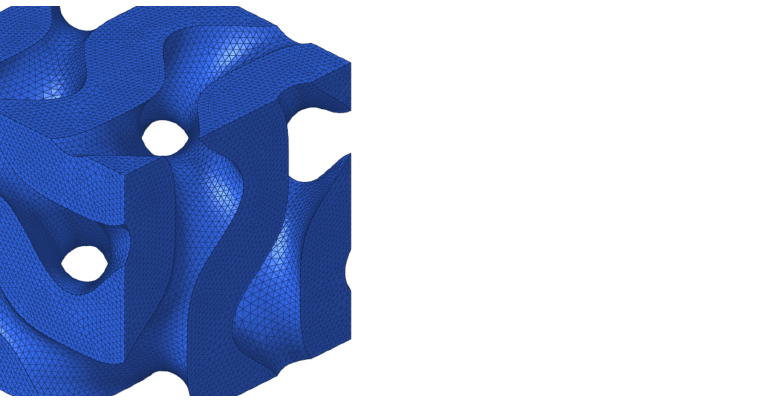
Figure 3. Example of a solid model of the gyroid structure unit-cell (50% relative